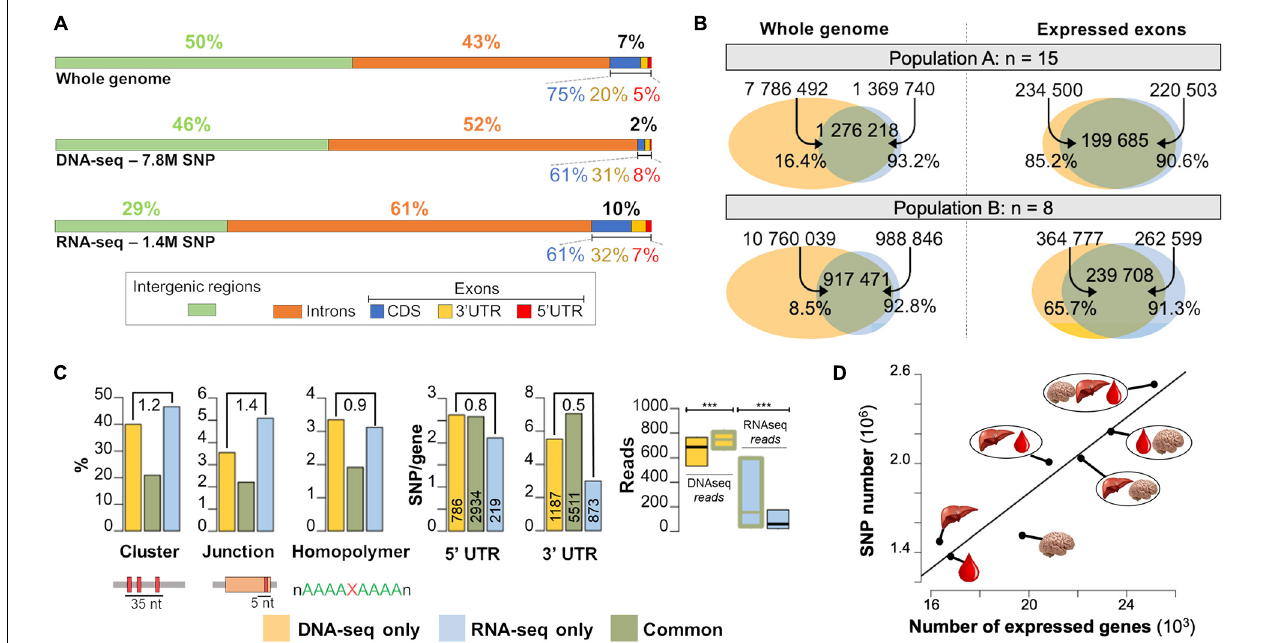
FIGURE 3 | Differences and common features of SNPs detected by RNA-seq and DNA-seq. (A) Percentage of the genome comprising each type of feature (top) and the proportion of SNPs detected by DNA-seq (middle) and RNA-seq (bottom) across these genomic features. (B) Number of SNPs detected by DNA-seq only (yellow set), RNA-seq only (blue set) and by both methods (gray set) at the whole genome level (left) and expressed exon level (right) in two independent populations A ( n = 15, layers) and B ( n = 8, broilers). (C) Left: Percentages of SNPs in SNP clusters (i.e., 3 or more SNPs in a sliding window of 35 bp, as per GATK definition), in junctions, homopolymers, in population A by DNA-seq only, RNA-seq only and both methods (common). Middle: Number of SNPs detected in 5 (cid:48) and 3 (cid:48) UTR by gene ( Y -axis) and the gene number (vertical numbers) in population A. The ratio “RNA-seq specific SNPs/DNA-seq specific SNPs” is indicated at the top of each plot. Right: read supporting SNP distribution at the population level in DNA-seq or RNA-seq data. (D) Evolution of the number of detected SNPs as a function of the number of expressed genes using one tissue alone or groups of tissues. Tissues used were liver (figured as a liver), blood (figured as a blood drop) and hypothalamus (figured as a